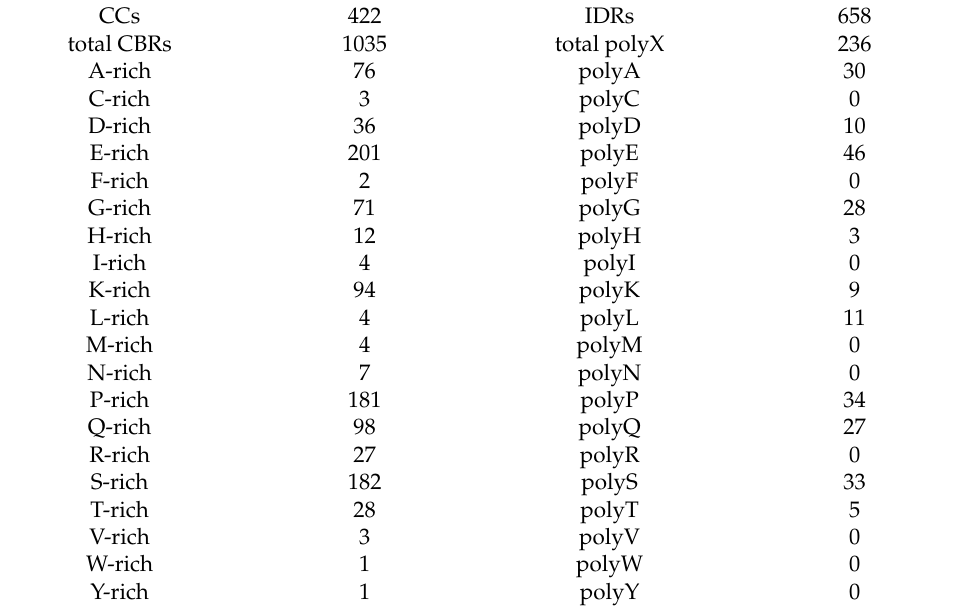
Figure 5. Conserved A-rich regions and bordering polyP in three HTT-interactors. ( A ) RASA1 (P20936). The polyP sequence (alignment coordinates 224–241) overlaps the end of a larger P-rich CBR (183–241), and occurs just after a much larger N -terminal A-rich region (3–222). All these LCRs are within a larger predicted IDR (1–263). ( B ) SYN2 (Q92777). The polyP sequence (31–42 in alignment) is within a larger P-rich CBR (29–91) and overlaps the start of an A-rich region (38–130). PolyP and P-rich regions are within a predicted IDR (1–100) but the A-rich region is partly outside. ( C ) KAT2B (Q92831). The polyP (154–164), above the threshold for D. rerio , overlaps a slightly longer P-rich region (154–169). They are near the end of a large N -terminal A-rich CBR (9–140), which overlaps with an IDR (8–127). Some of the sequences in the alignments may miss fragments and could have been replaced by better versions, but we have left them as given for simplicity (see Discussion). Table 2. The number of low complexity regions (LCRs) detected in 402 human HTT-interactors and orthologs in 10